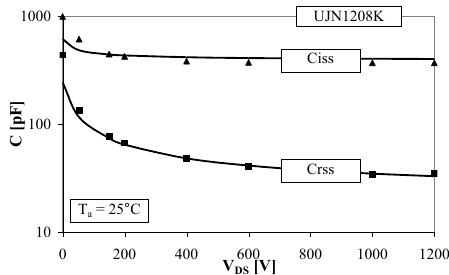
Fig. 3. Calculated and catalogue C-V characteristics of the transistor UJN1208K at 25 °C